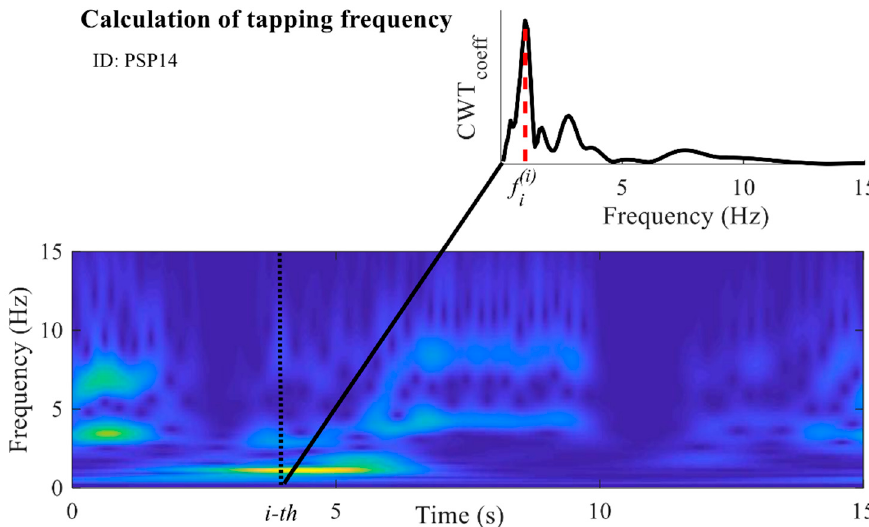
Figure 6. Calculation of the frequency characteristic: scalogram of the obtained continuous wavelet transform (CWT) coe ffi cients. The dashed black line marks the i -th sample. The CWT coe ffi cients at the i -th sample are presented in the smaller upper panel. The red dashed line in the upper panel marks the frequency with the highest amplitude of the CWT coe ffi cients for the i -th sample (referred to as f i ( i ) ). The example is given for one PSP patient (ID: PSP14).